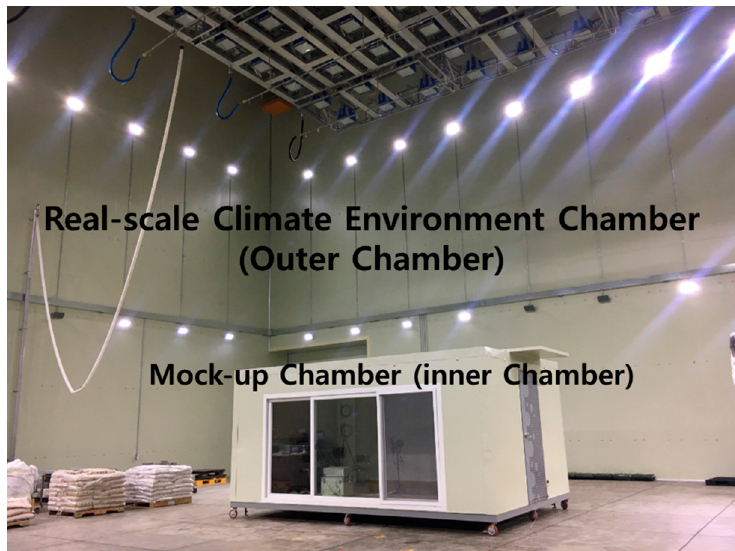
Figure 15. View of real-scale climate environment chamber and mock-up chamber for experiment.